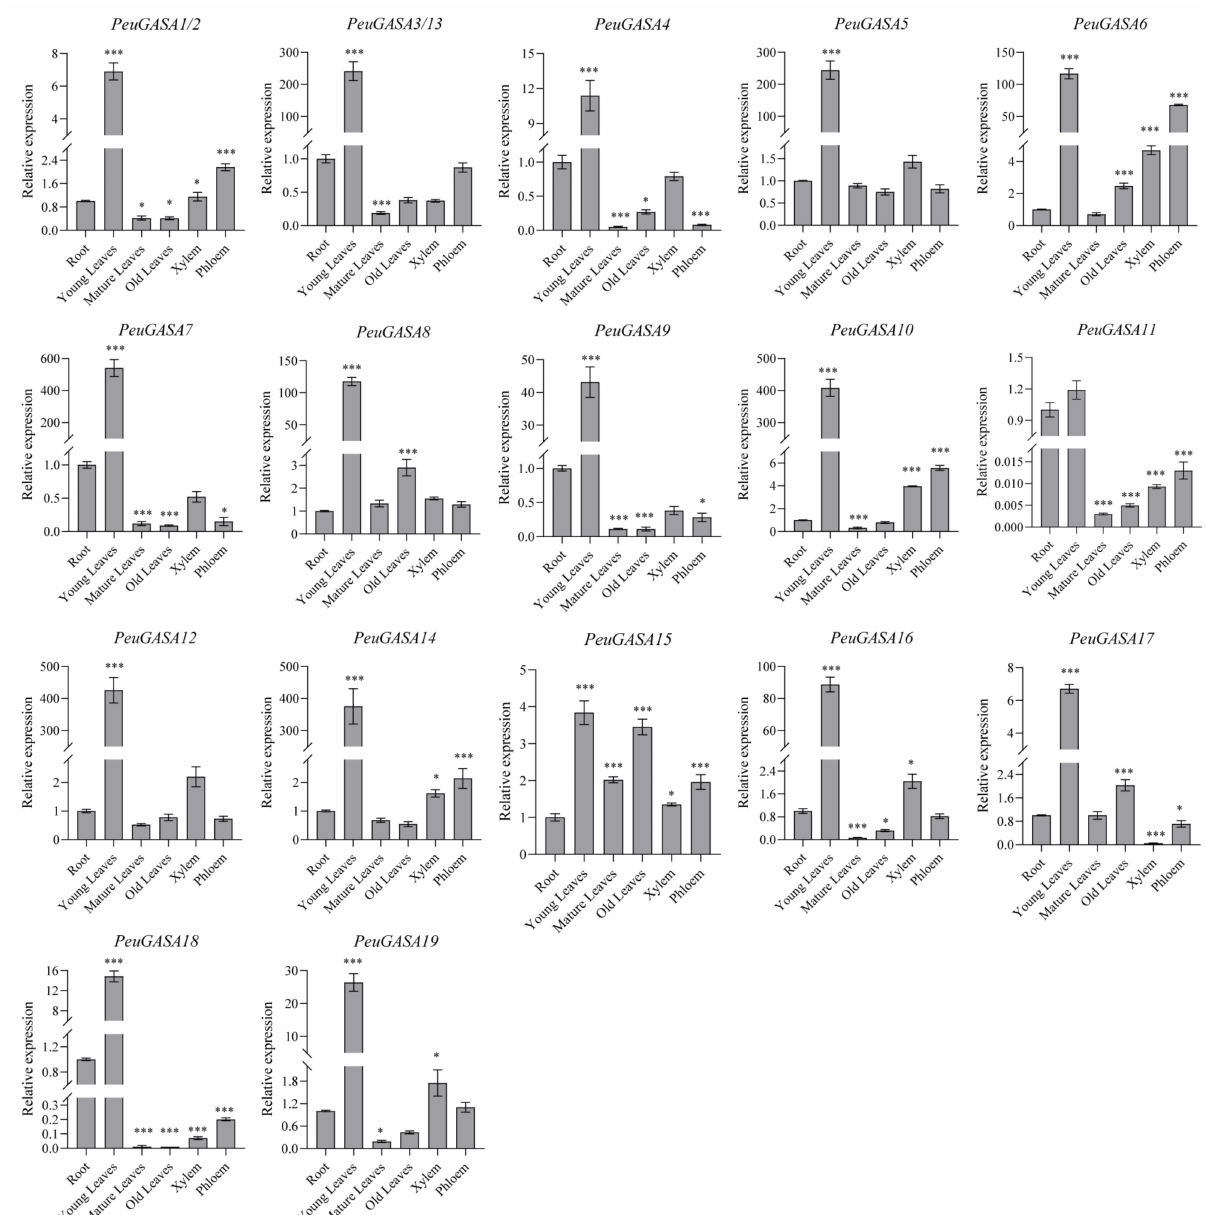
Figure 6. Expression patterns of GASA genes in different P. euphratica tissues. Data were presented as mean ± standard error (SE). Subsequent multiple comparisons were evaluated based on the least significant difference (LSD) test to calculate p -values (Asterisks denoted significant differences: * p ≤ 0.05; *** p ≤